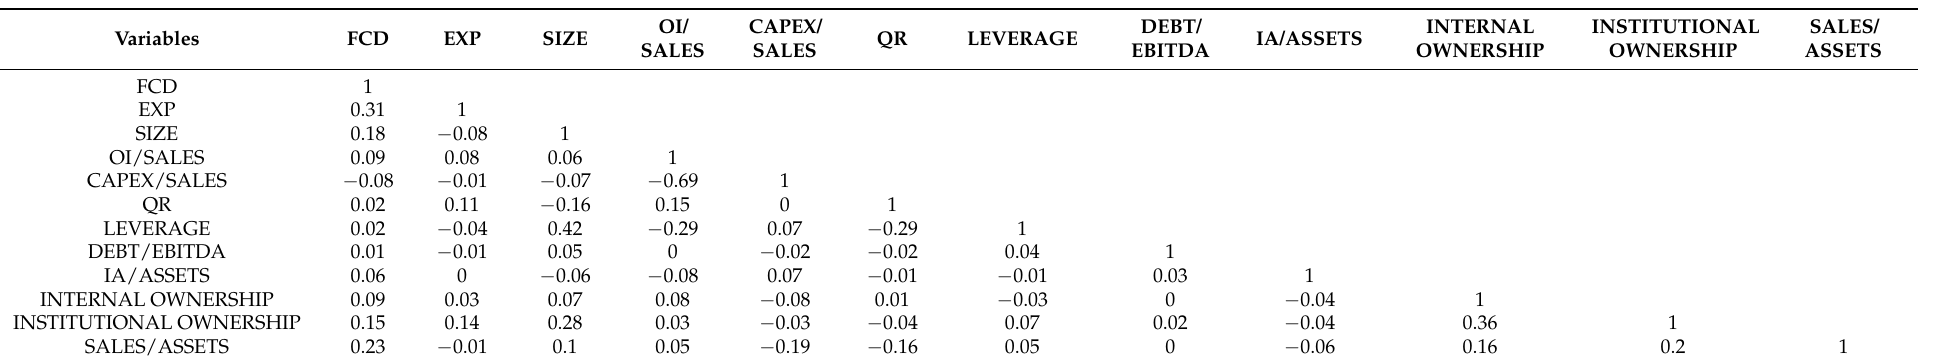
Table A2. Correlation